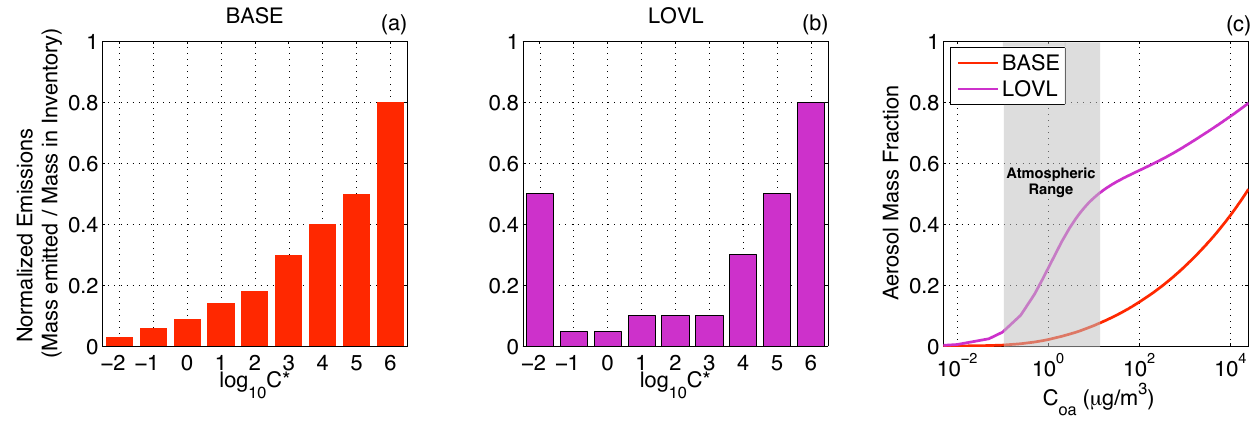
Fig. 3. Volatility distribution of POC emissions for (a) BASE and (b) LOVL scenarios as a fraction normalized to the traditional POC emission inventory total. Panel (c) shows the change in aerosol mass fraction for the BASE and LOVL volatility distributions as a function of C OA at 298K. The normalized SVOC emissions fully represent the traditional POC emission inventory and hence sum to 1. The normalized IVOC emissions are 1.5 times the emission inventory and hence sum to